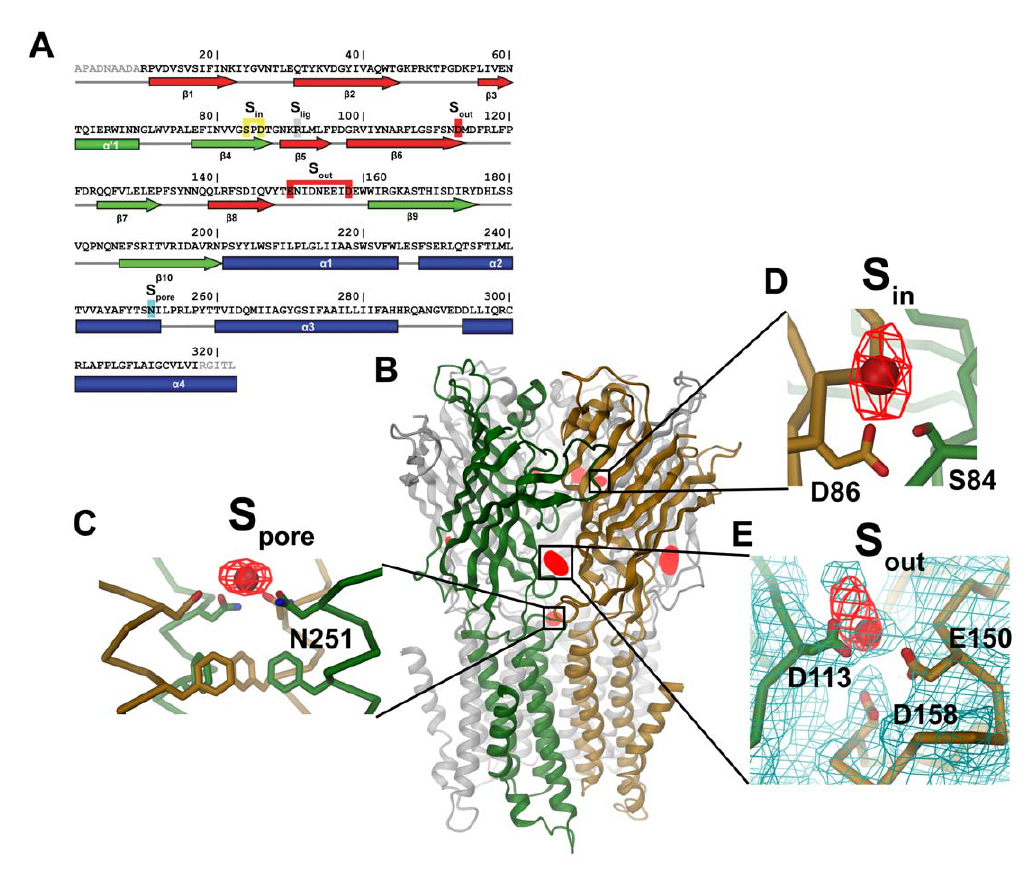
Figure 3. Structure of ELIC in complex with divalent cations. (A) Sequence of ELIC with secondary structure elements indicated below. Residues contributing to ion coordination in different sites are highlighted (S in , yellow; S out , red; S pore , cyan; Arg 91 in the ligand-binding pocket, S lig , grey). (B) Anomalous difference electron density of ELIC in complex with Ba 2 + superimposed on the structure of the ELIC pentamer (shown as ribbon representation). Ion-binding sites are labeled. Close-up of S pore (C) and S in (D). The protein is shown as C a -trace with selected side-chains close to Ba 2 + (red sphere) shown as sticks. (E) Close-up of S out . The protein is shown as C a -trace with selected side-chains close to Ba 2 + (red sphere) shown as sticks. The 2F o -F c electron density of a dataset from a crystal of space group P2 1 was calculated at 3.8 A˚ and contoured at 1 s (shown in cyan). The refined model used to calculate phases did not contain Ba 2 + -ions. The anomalous difference electron densities shown in (B–E) (red mesh) were calculated from the same dataset at 5 A˚ and contoured at 5 s . Crystals of space group P4 3 showed a qualitatively similar picture. Structures in Figures 3–7 were prepared with DINO